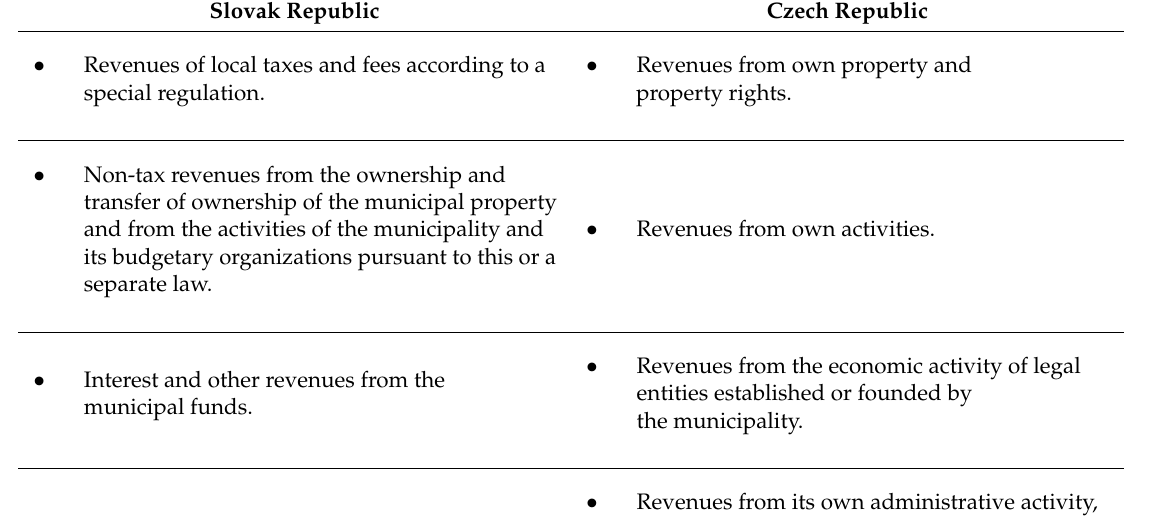
Table 2. The structure of revenues of municipalities in Slovak Republic and in Czech